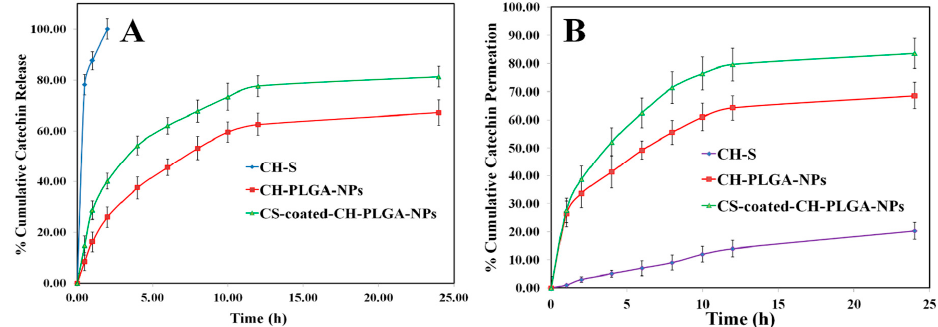
Figure 8. ( A ) In vitro release profile of CS–S, CH-loaded–PLGA–NPs, and